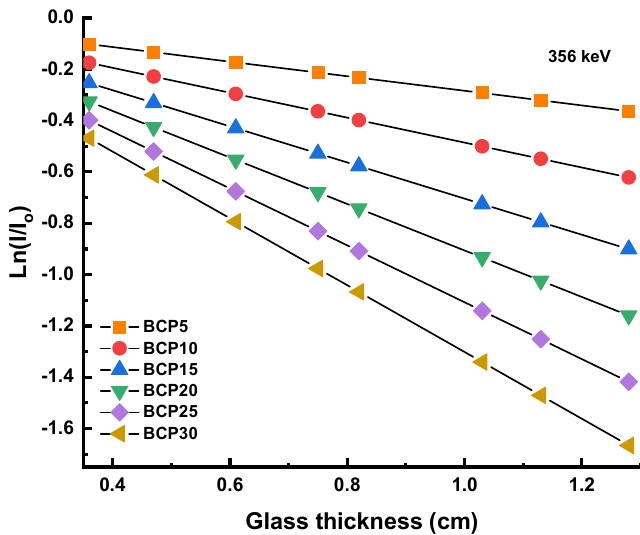
Figure 3. Graph of Ln(I/I o ) against glass thickness at 356 keV.